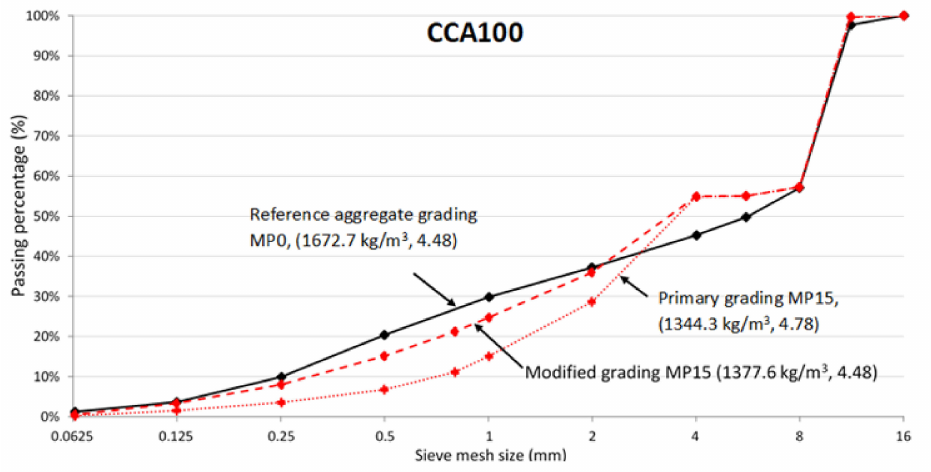
Figure 4. Combined grading curves CCA100 (packing density, fineness